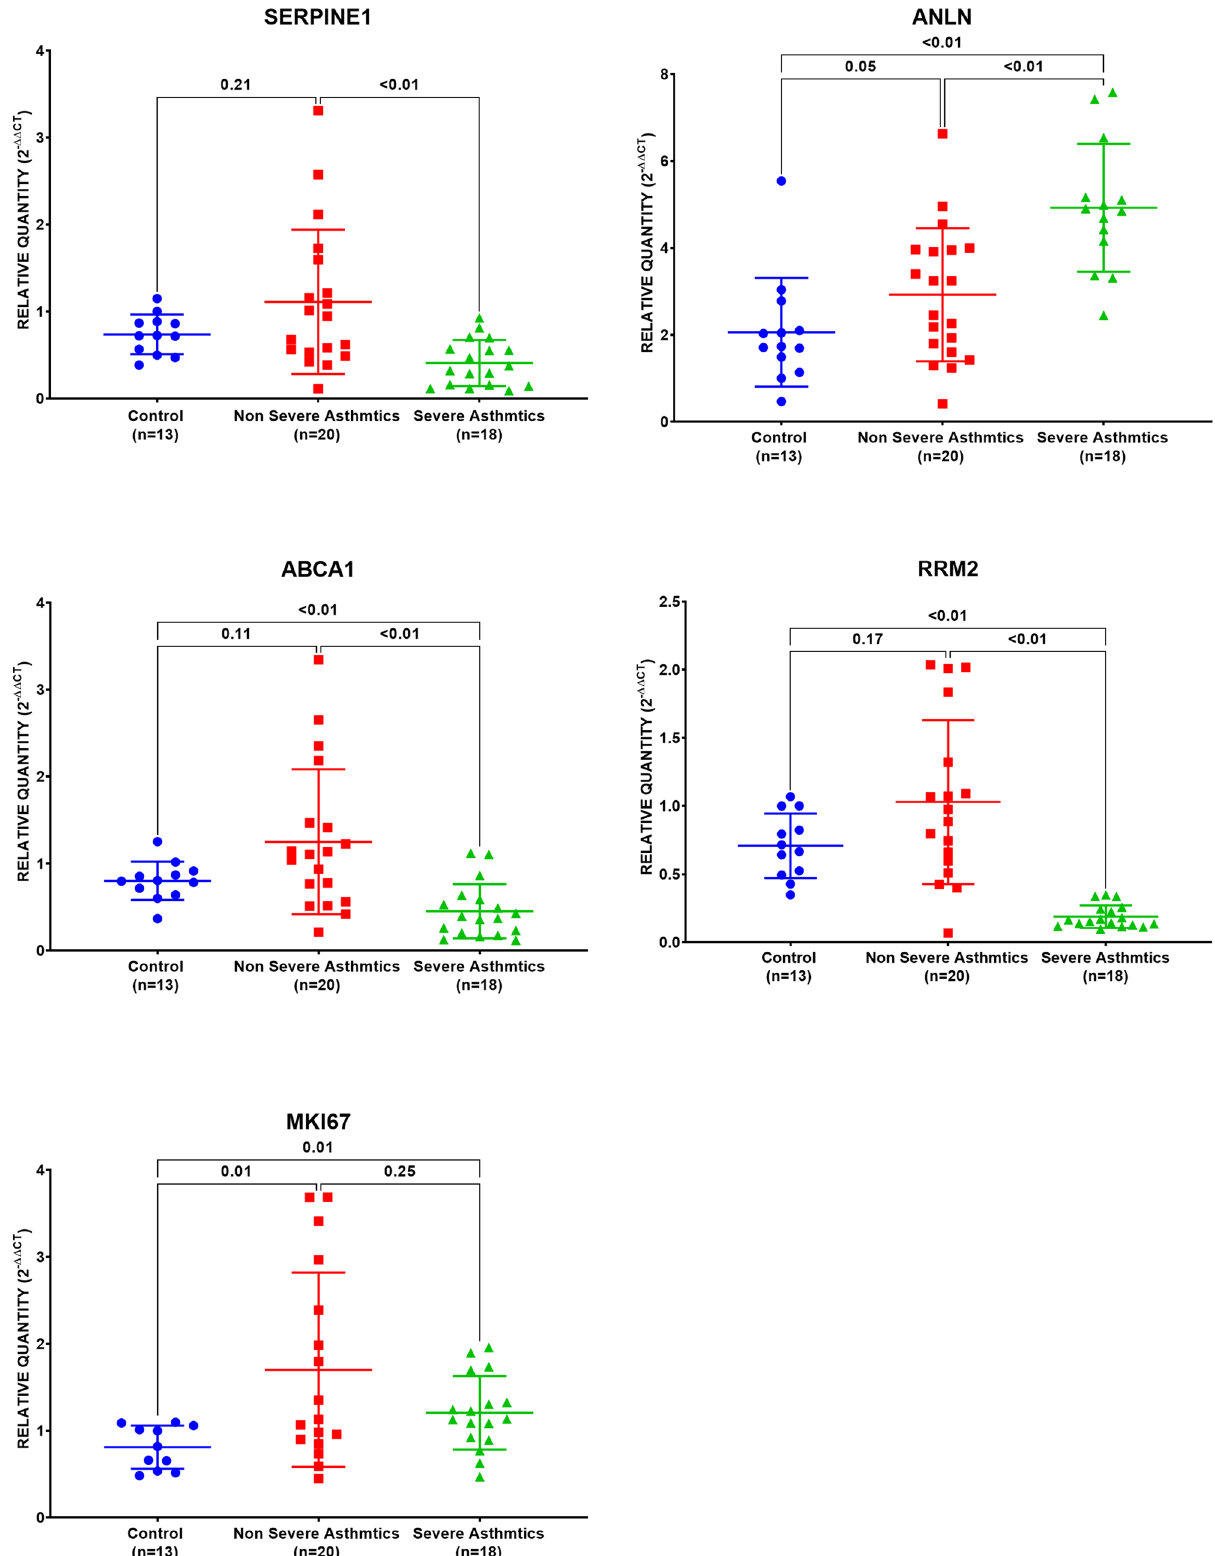
Figure 12. mRNA gene expression using RT qPCR of the ten genes in PBMC of the locally recruited cohort, healthy controls (n = 13), Nonsevere asthmatics (n = 20), and severe asthmatic (n =